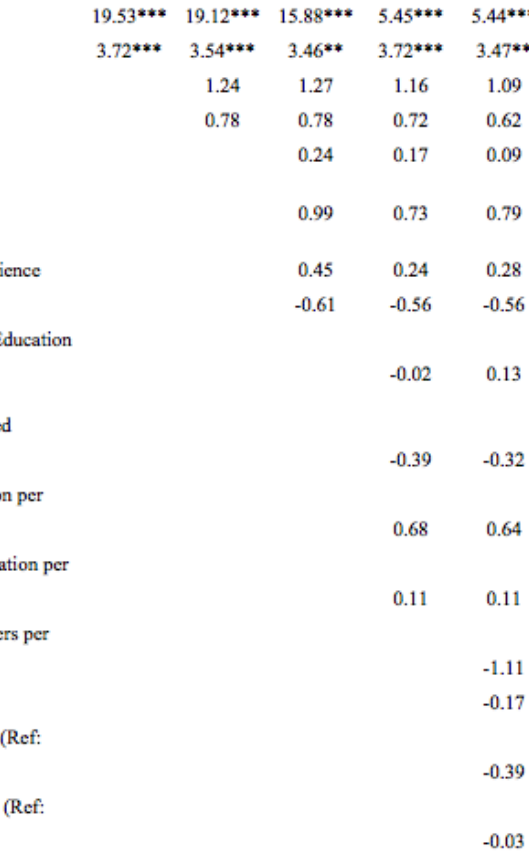
Summary of Multilevel Regression Analyses for Predicting Personal Accomplishment by Perceived Support in Special Education Teachers (standardised